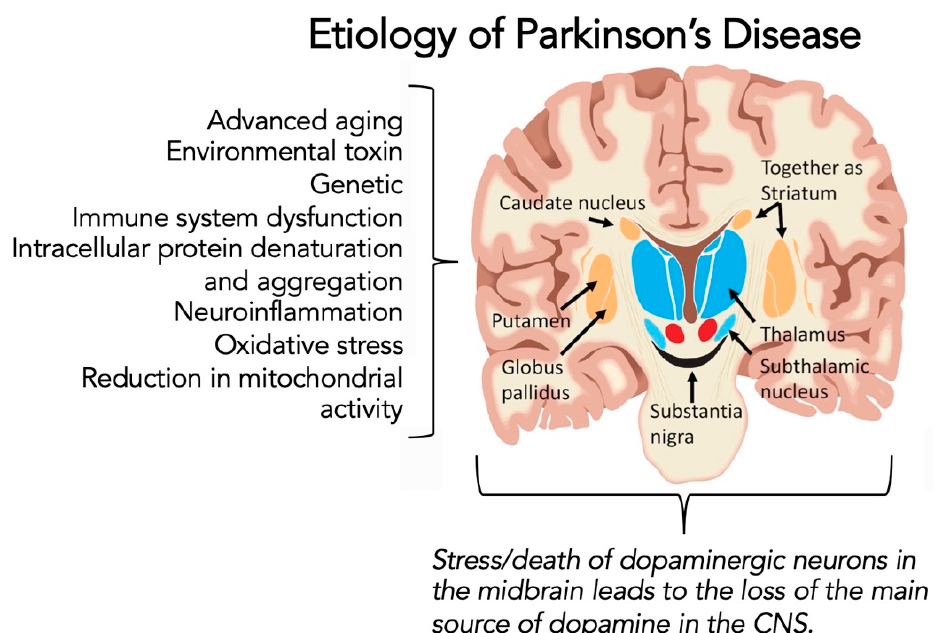
Figure 1. Etiology of Parkinson’s disease showing the major causes of the disorder that promote the loss of dopaminergic neurons in the substantia nigra pars compacta mid-brain region. Abbreviation used: CNS, central nervous system.